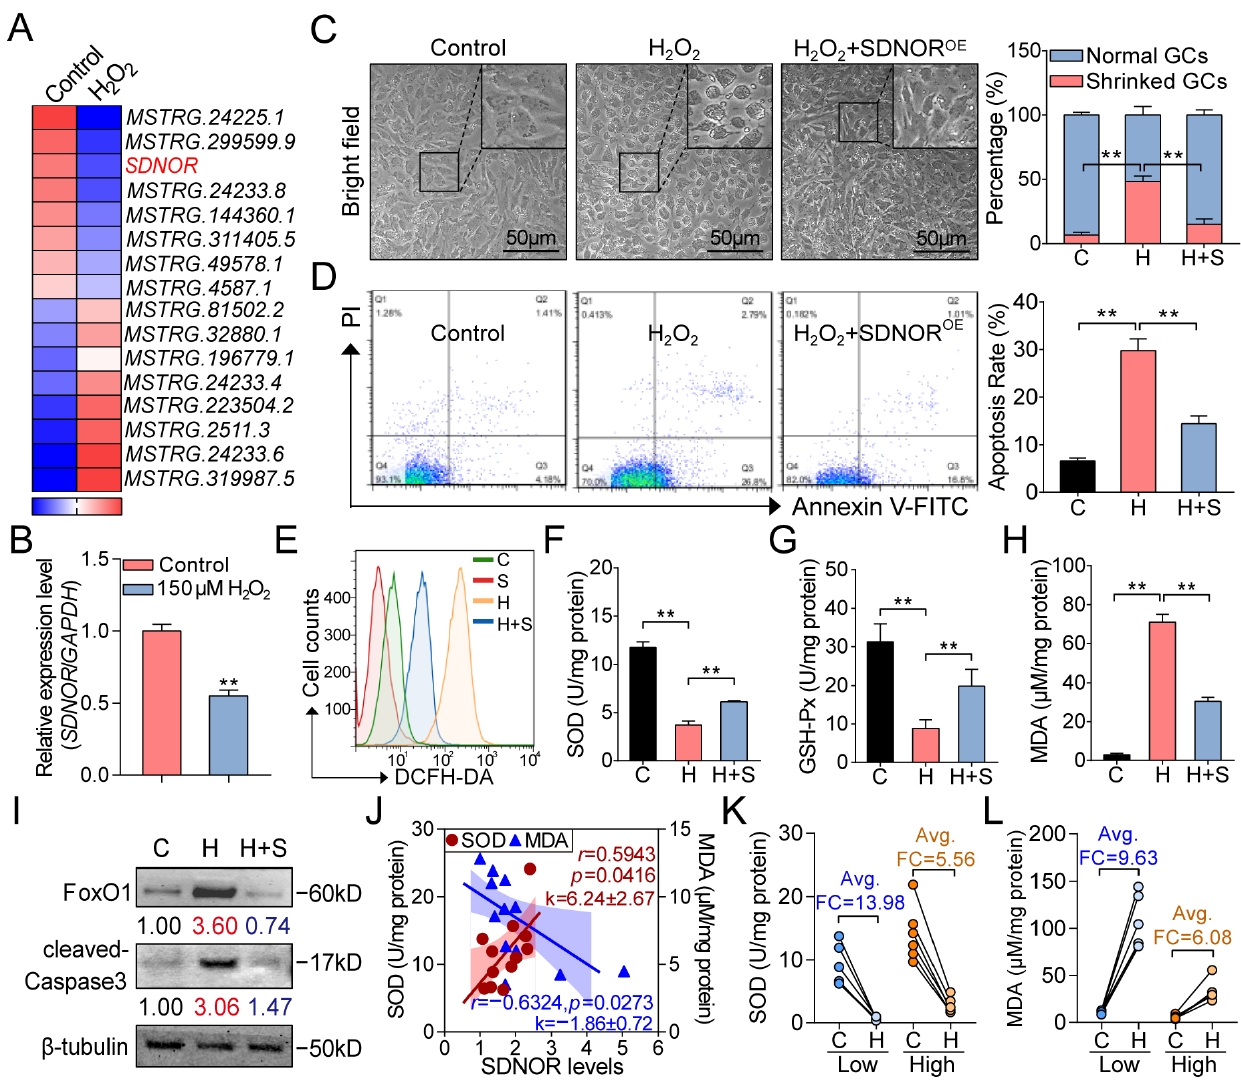
Figure 7. SDNOR is a novel antioxidative lncRNA in porcine GCs. ( A ) Heatmap showing the expression pattern of DElncRNAs in porcine GCs under oxidative stress, SDNOR is indicated in red. ( B ) The effects of 150 µ M H 2 O 2 on the expression of SDNOR were detected by RT-qPCR. ( C–E ) GCs were treated with SDNOR OE under oxidative stress; cell viability ( C ), apoptosis rate ( D ), and ROS accumulation ( E ) were analyzed by microscopic observation and FACS. Specifically, C, H, and S indicate control, H 2 O 2 , and SDNOR OE , respectively. ( F–H ) The activities of SOD ( F ) and GSH-Px ( G ) and the MDA levels ( H ) in GCs co-treated with 150 µ M H 2 O 2 and SDNOR OE were detected by ELISA. ( I ) The protein levels of FoxO1 and cleaved-caspase3 in GCs under different conditions were detected by Western blot. ( J ) The relationship between SDNOR levels and SOD activities and